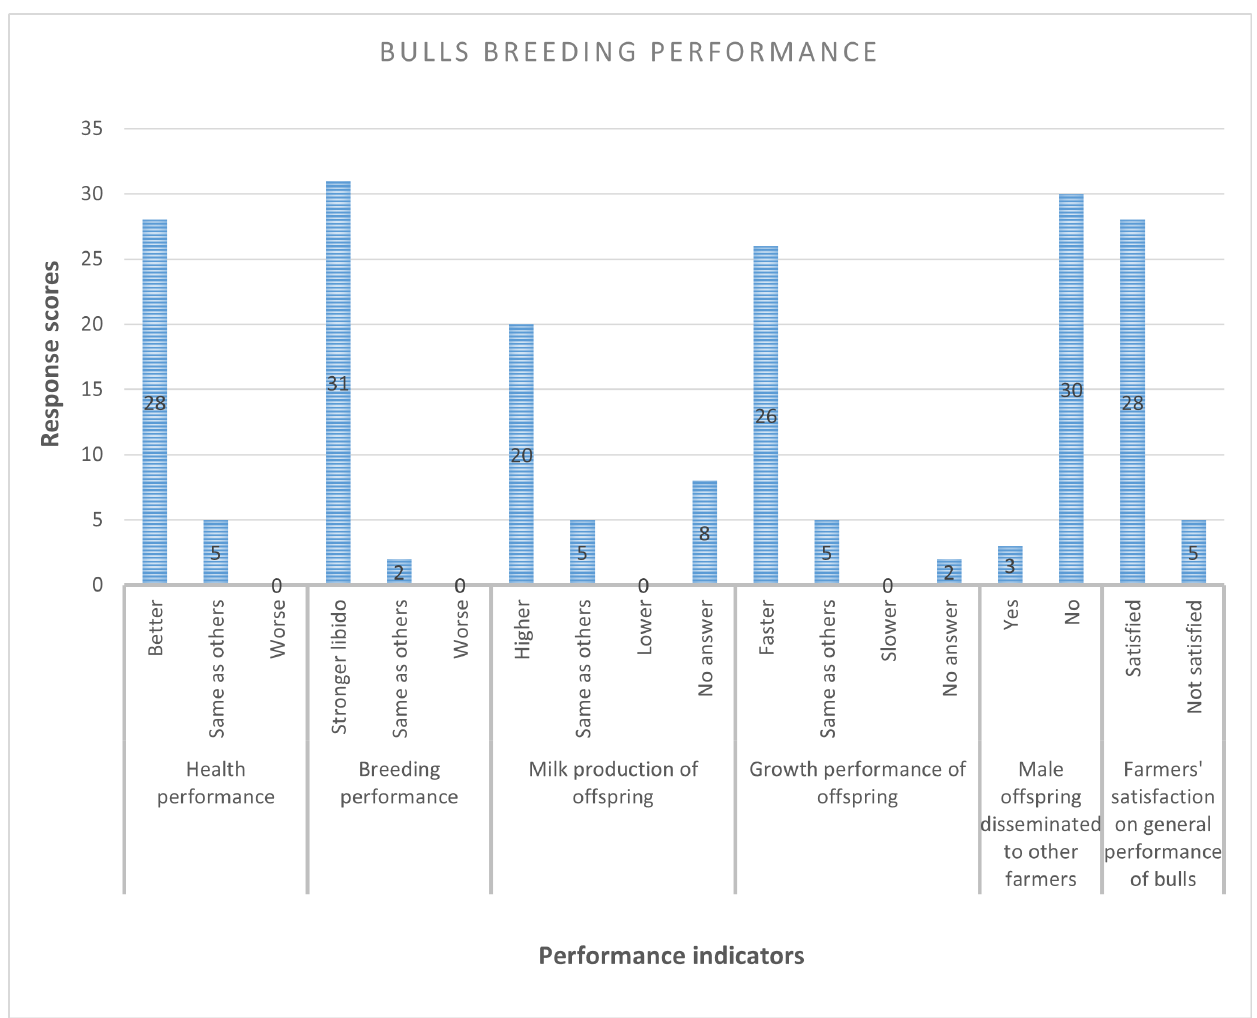
Figure 3. Responses of 33 Multiplier tier farmers to bulls breeding performance indicators Table 3. Challenges confronting livestock producers and proposed